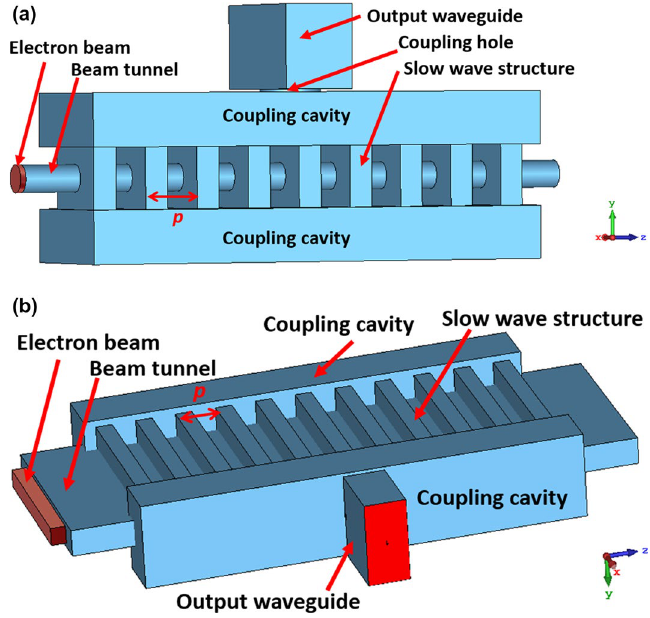
Figure 1. The schematic drawings of a pencil-beam EIO ( a ) and a sheet-beam EIO ( b ). Both drawings show the vacuum enclosures of the EIO